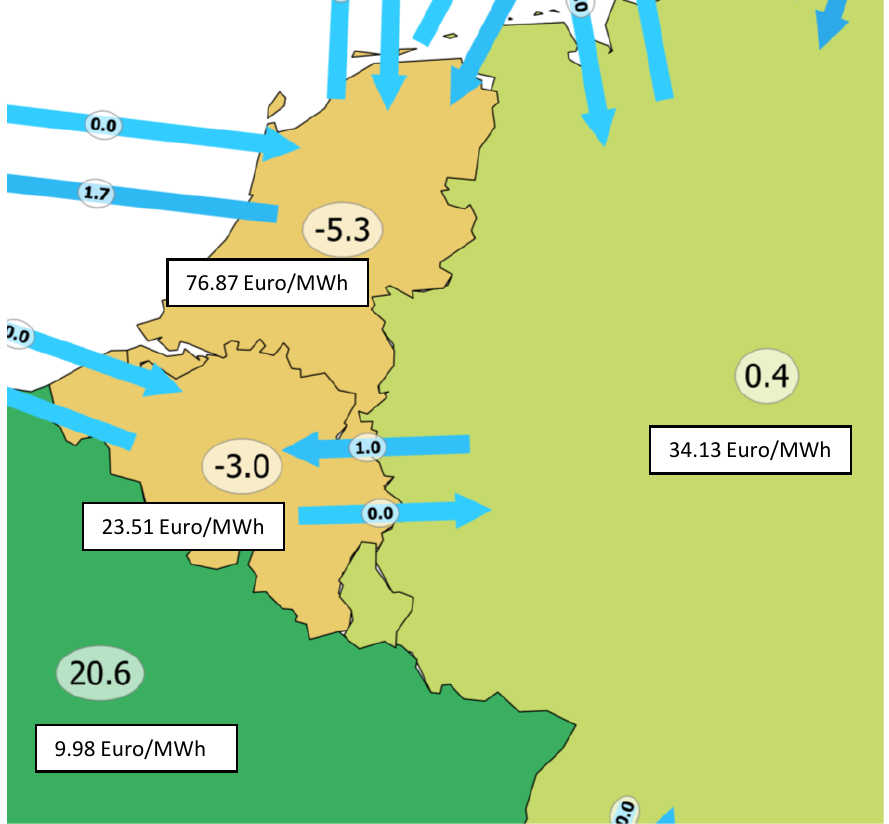
Figure 16. Aggregated flows and net positions in TWh in hour